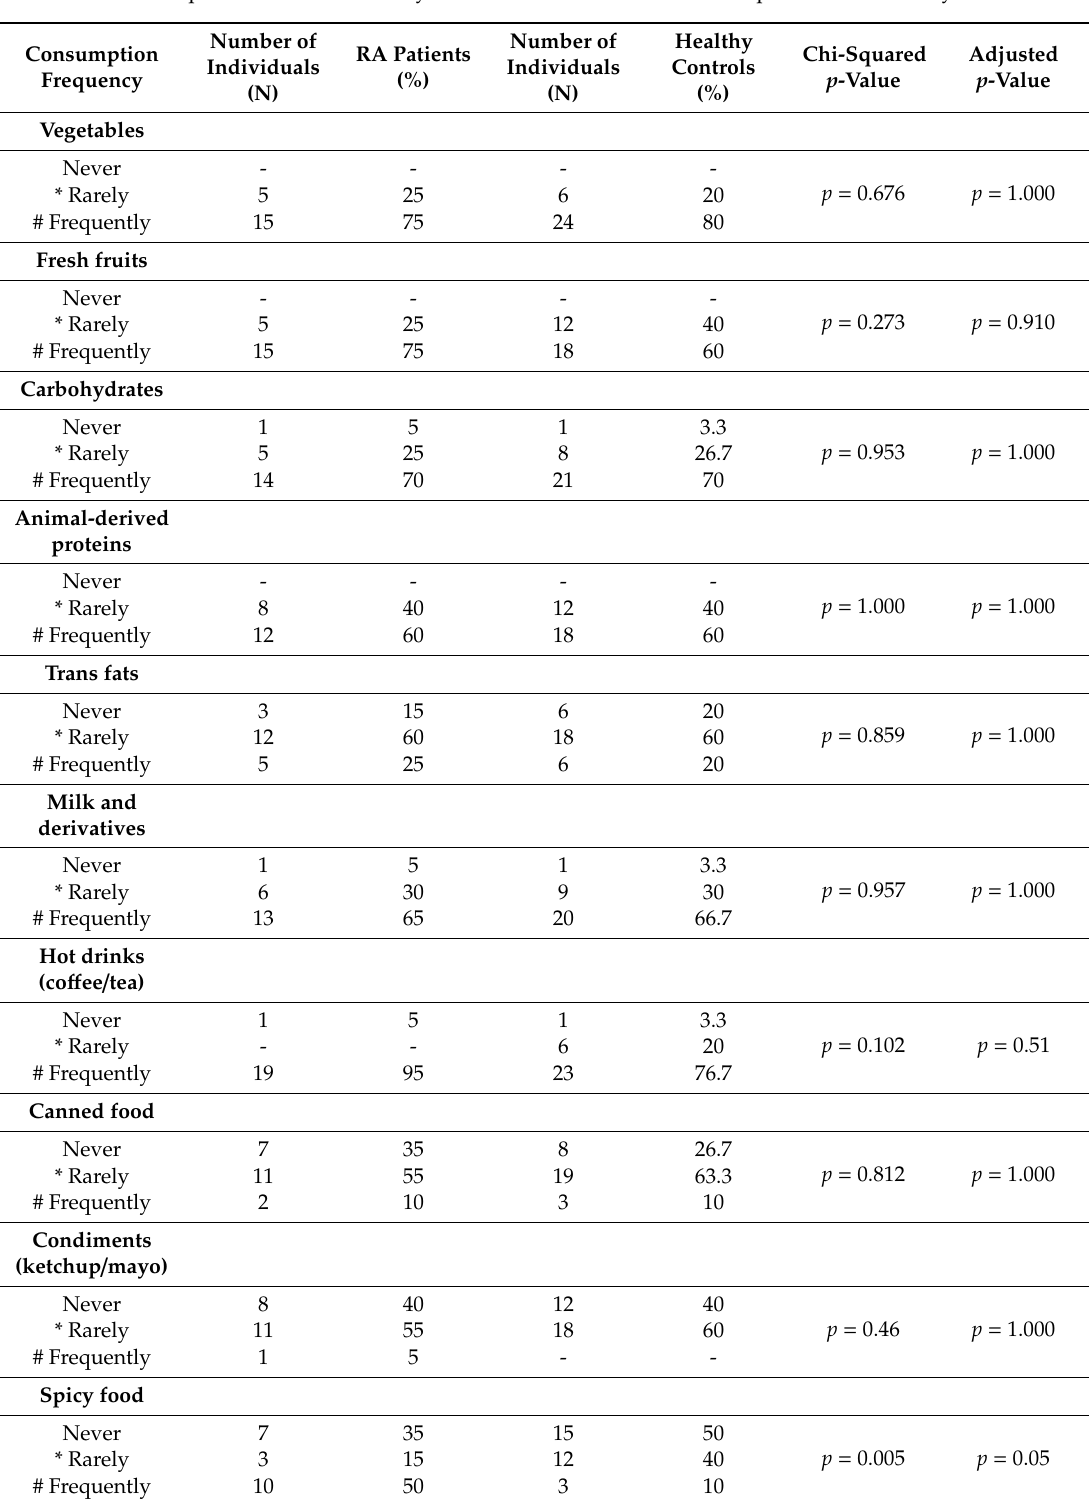
Table 2. Description of the main dietary habits of the rheumatoid arthritis patients and healthy controls.